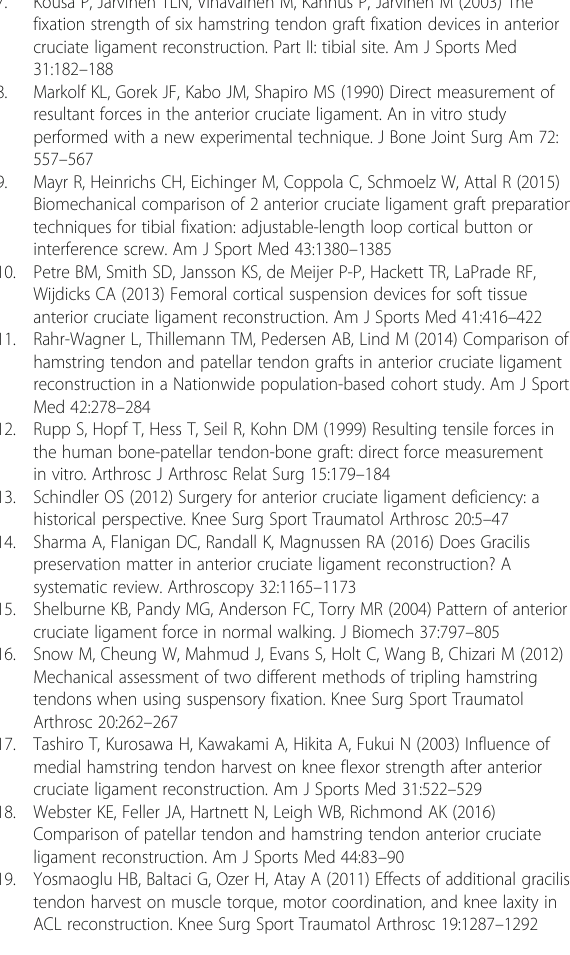
Abbreviations ACL: Anterior cruciate ligament; ST: Semitendinosus tendon; STG: Doubled semitendinosus and gracilis; TR: